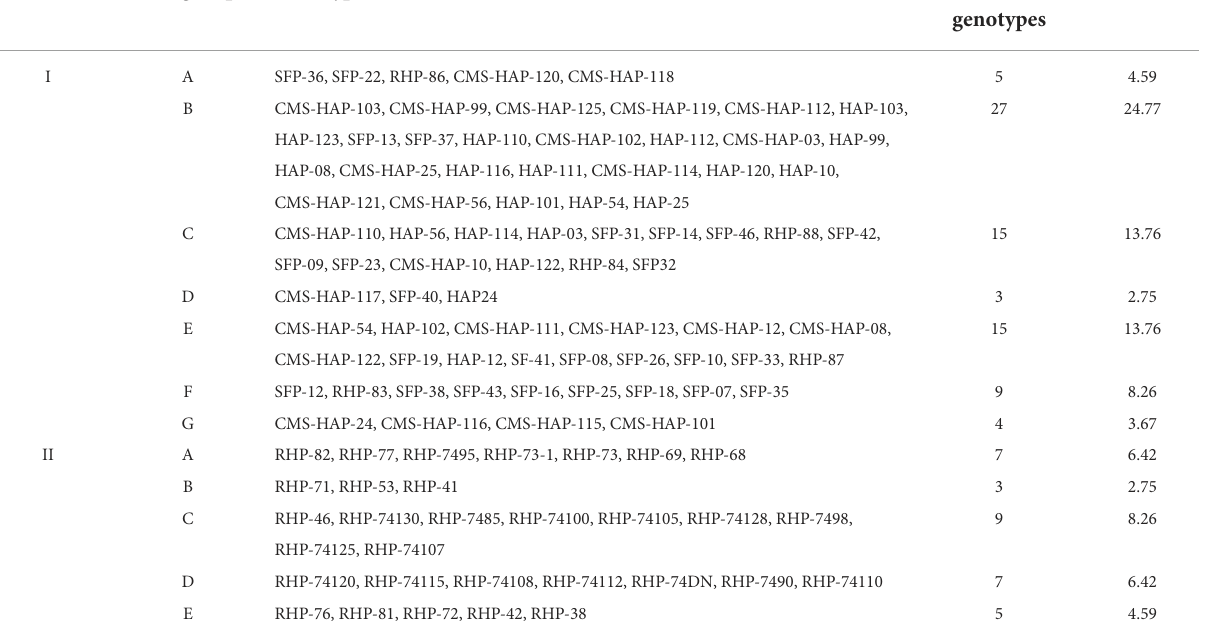
TABLE 5 Grouping of 109 sunflower genotypes based on SSR markers dendrogram. Cluster Sub-group Genotypes No. of